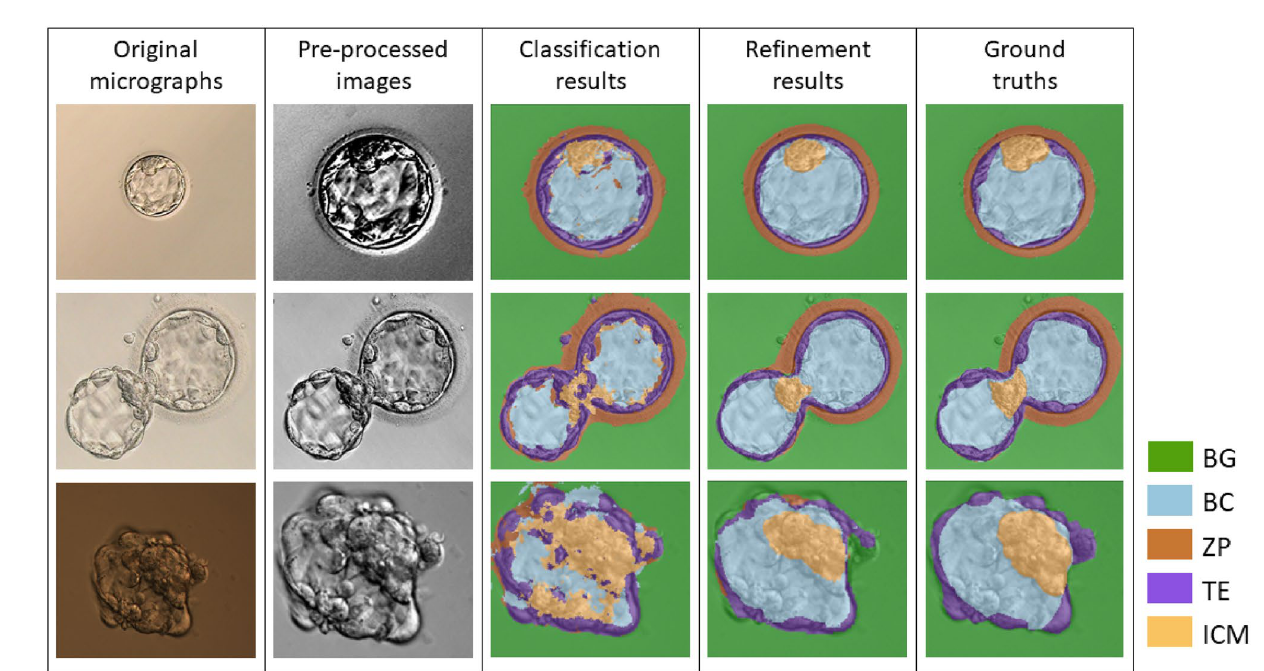
Figure 2. Examples of the original blastocyst micrographs, the images after pre-processing, before and after the segmentation refinement, and the ground truth. Please note that these images might have been stretched, shrunk, or cropped for aesthetic purposes, but the pixel values remained